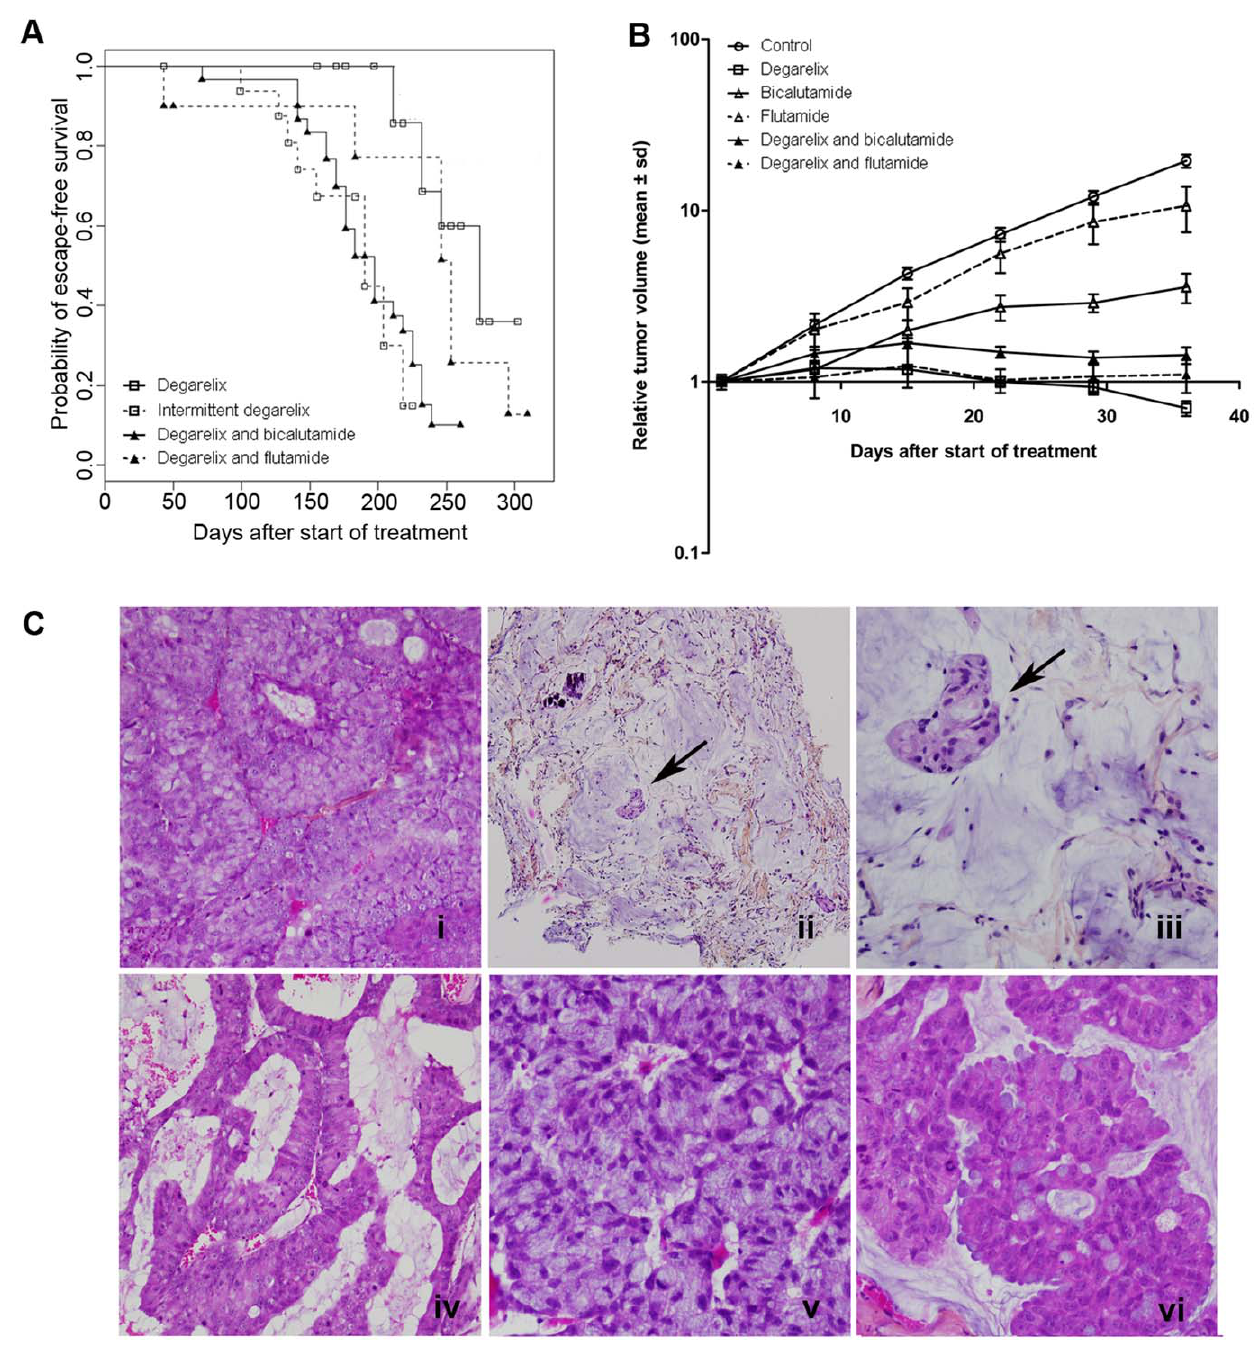
Figure 1. PAC120 xenograft tumor response to androgen deprivation treatment regimens. A ) Kaplan-Meier analysis of hormone escape- free survival after continuous (white square, full line), intermittent (white square, dotted line) degarelix, bicalutamide plus degarelix (black triangle, full line) or flutamide plus degarelix (black triangle, dotted line). B ) Tumor growth curves as a function of time in control (white cercle, full line), bicalutamide (white triangle, full line), flutamide (white triangle, dotted line),degarelix (white square, full line), bicalutamide plus degarelix (black triangle, full line) and flutamide plus degarelix (black triangle, dotted line); C i) PAC120 xenograft [x200], residual PAC120 tumor (300 days) ii)[x100], iii) [x400], AI variants with adenoid features (iv) [x100], amphicrine features (v) [x200], and mucosecretant features (vi)